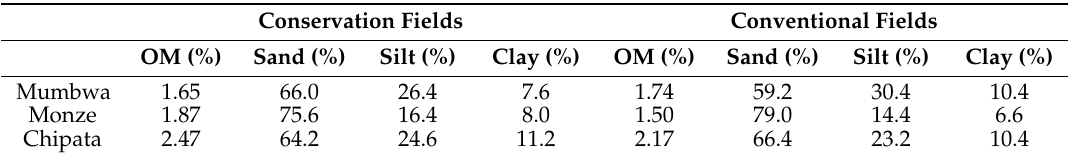
Table 2. Mean pairwise ratios of organic matter content (OM) and texture for the conservation (CA) and conventional (CV) fields tested for water infiltration and soil moisture. OM Sand Silt Clay Average of 15 CA/CV ratios 1.06 ± 0.26 Student’s t -test against expected mean of 1.00 ( p